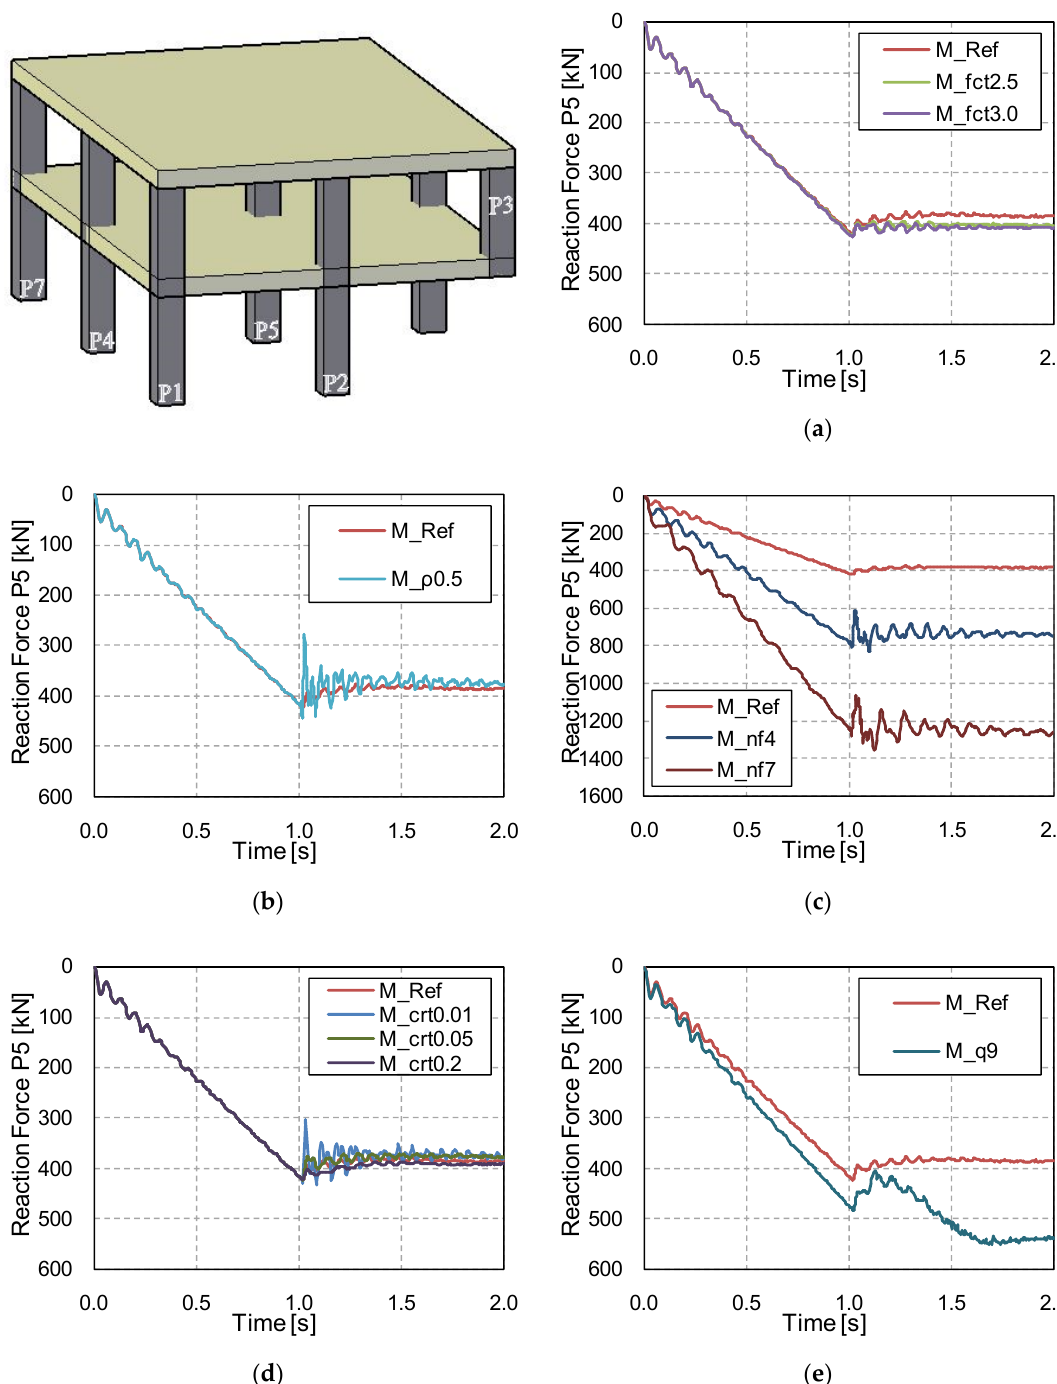
Figure A3. Numerical reaction in P5 obtained by varying ( a ) concrete tensile strength, ( b ) flexural reinforcement ratio, ( c ) number of floors, ( d ) column removal time, and ( e ) superimposed load. Positive values indicate compression.